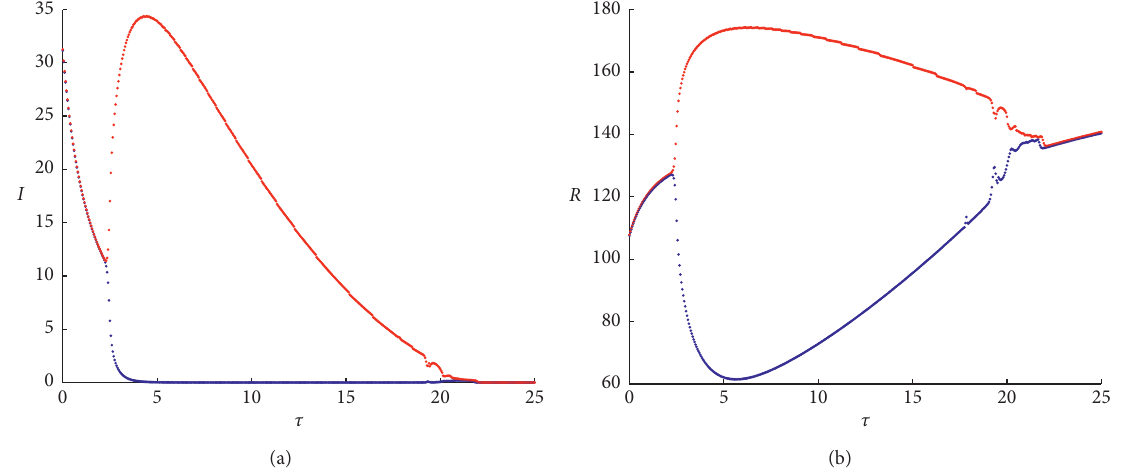
( τ ) > 1: (a) the periodic solution; (b) the phase diagram. when R ∗ 0